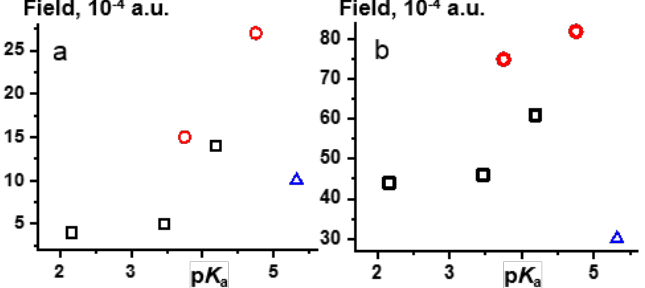
Figure 5. The lower limit of the external electric field simulated the effect of CDF 3 /CDClF 2 on 2 , 3 , 5 (black □), 4 , 6 (red ○ ), and 1 (blue ) under the PCM ( a ) and gas-phase ( b ) approximations as a function of the p K a of the proton-donor.